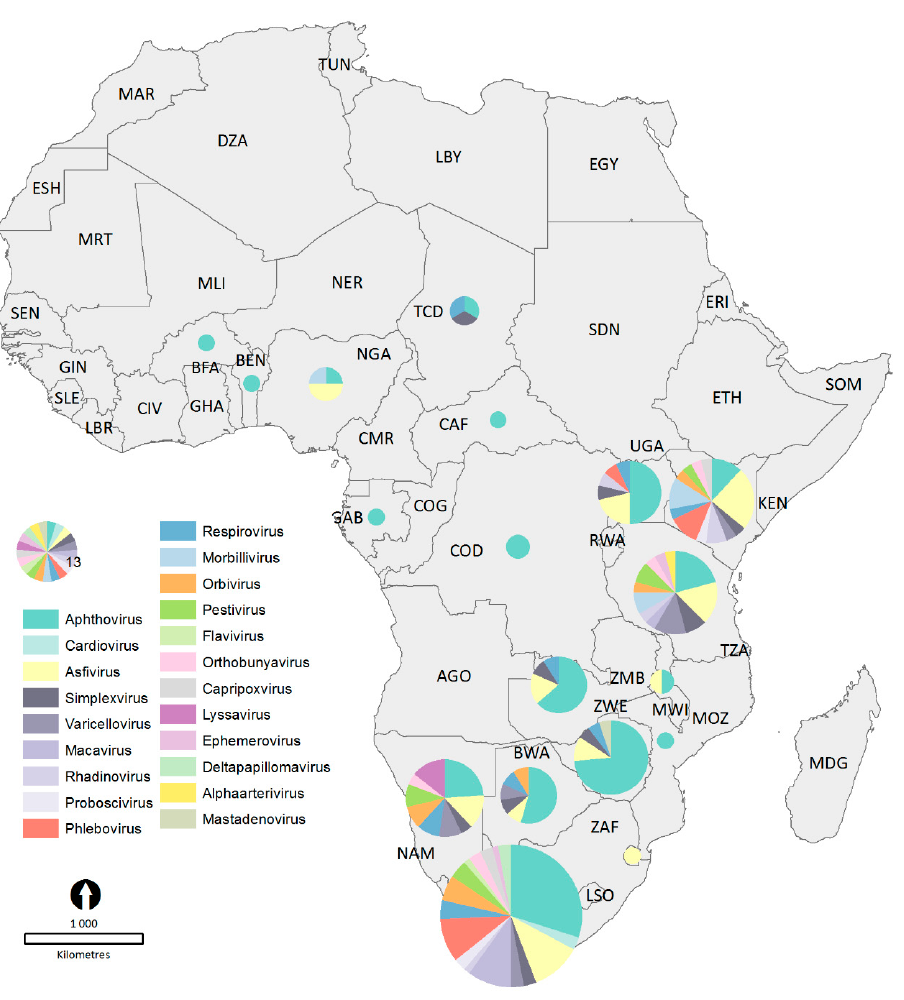
Figure 4. Geographical distribution of publications reporting on viruses in African ungulates.